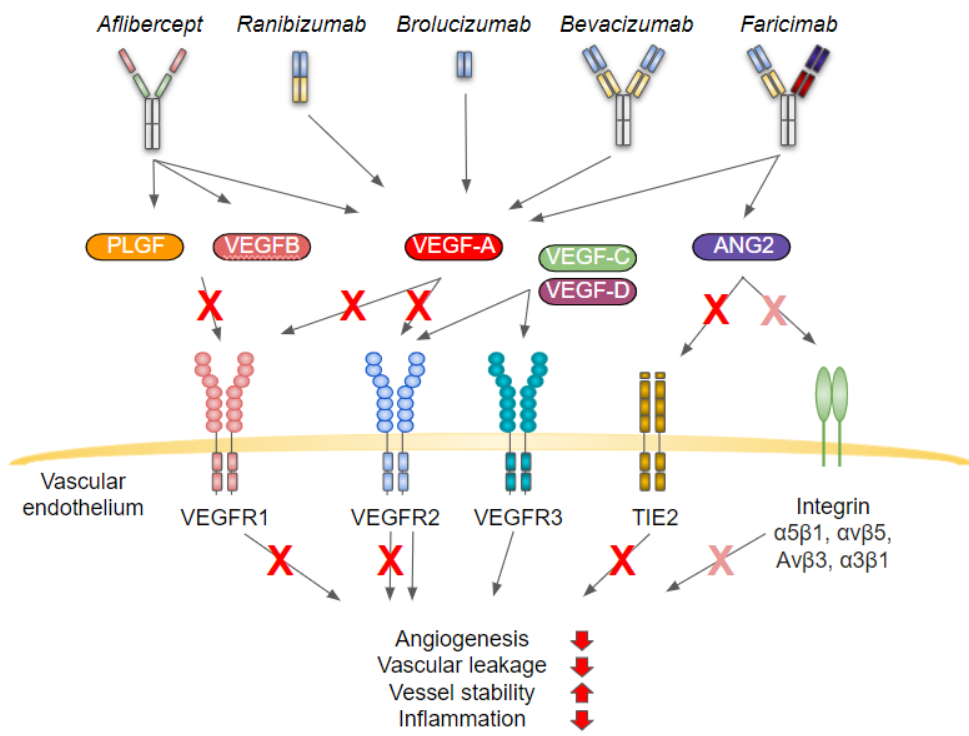
Figure 2. Mechanism of action of anti-VEGF treatments currently used to treat neovascular age related macular edema. Activation of VEGFR2 by VEGF-A plays a major role during angiogenesis, the role of VEGFR1 and VEGFR3 during neovascularization is less pronounced. Binding of ANG2 to TIE2 and Integrin α 5 β 1, α v β 5, α 3 β 1 and α v β 3 will further contribute to vascular destabilization, increased inflammation and enhanced angiogenesis. All the antiangiogenic agents used to treat age related macular degeneration, binding to VEGF-A and prevent its signaling. Aflibercept, which is a fusion protein, will also bind to PLGF and VEGF-B. Faricimab instead is a bi-specific antibody and will bind to both ANG2 and VEGF-A. Whether faricimab will inhibit binding of ANG2 to integrins is less well characterized than its capability to intervene with ANG2-TIE2 signaling. Both ranibizumab and brolucizumab antibody fragments that inhibit VEGF-A signaling. Brolucizumab is a hu- manized monoclonal single-chain Fv (scFv) antibody fragment and ranibizumab is a humanized monoclonal antibody fragment. VEGF-C and VEGF-D are ligands for both VEGFR-3 and VEGFR-2 and may mediate pro-angiogenic signals even in the presence of previously mentioned anti-VEGF treatments. Abbreviations: PLGF, placental growth factor; VEGF, vascular endothelial growth fac- tor; ANG, angiopoietin; VEGFR, vascular endothelial growth factor receptor, TIE, tyrosine kinase with Ig and EGF homology domains.